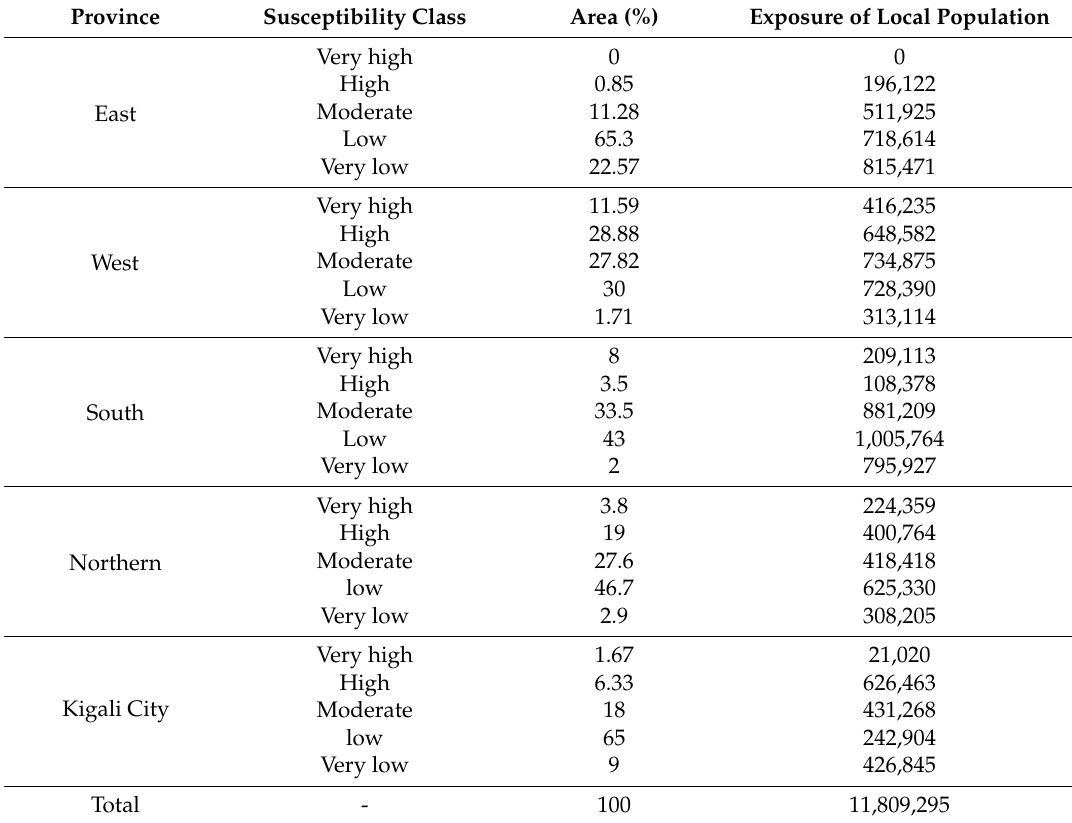
Table 5. Rwanda Population exposure within each susceptibility category per